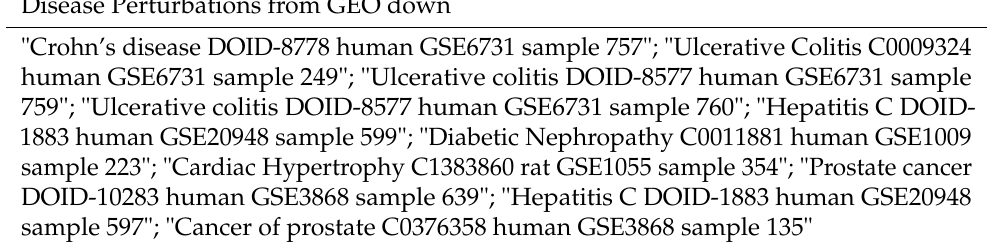
Table 10. Ten and four commonly selected diseases from Figure